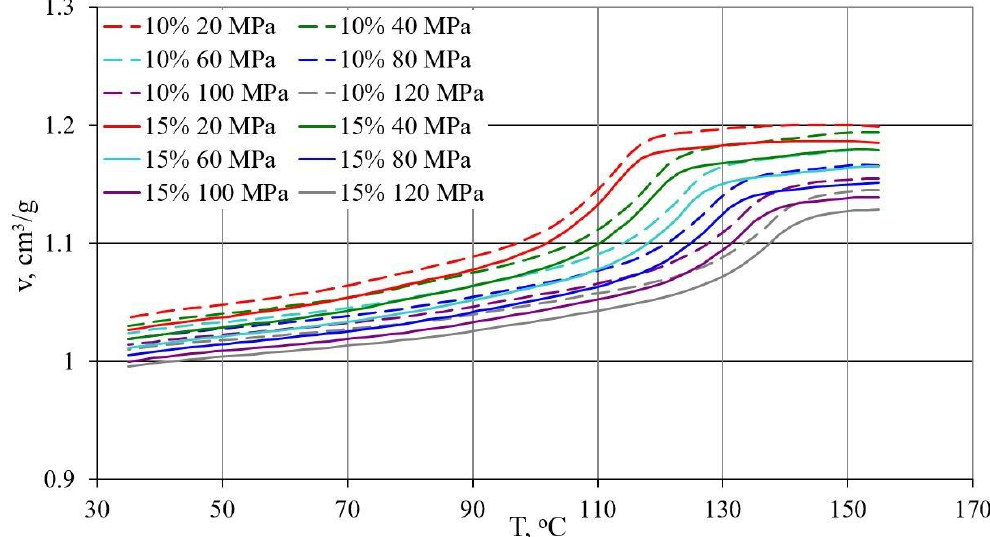
Figure 15. Dependence of specific volume v on temperature T for PE with 10% (dashed lines) and 15% (continuous lines) content of the fraction <0.4 mm of bran, at different pressure values.